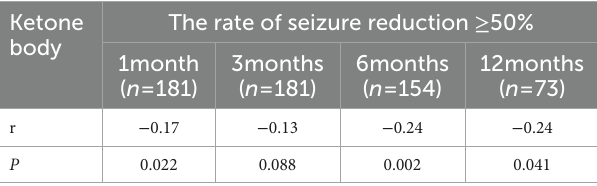
TABLE 4 The relation between ketone body and the rate of seizure reduction ≥ 50% at different follow up time. Ketone body